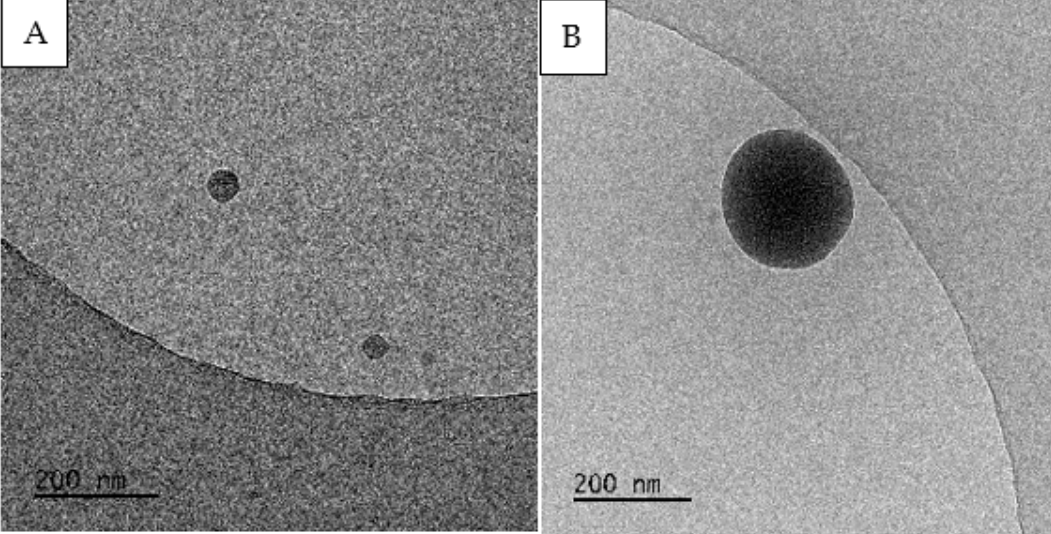
Figure 5. Examples of TEM images of samples after the fourth step of extraction (R1 ex4 and R2 ex4), presenting 40 nm ( A ) and 200 nm ( B ) markers, respectively.